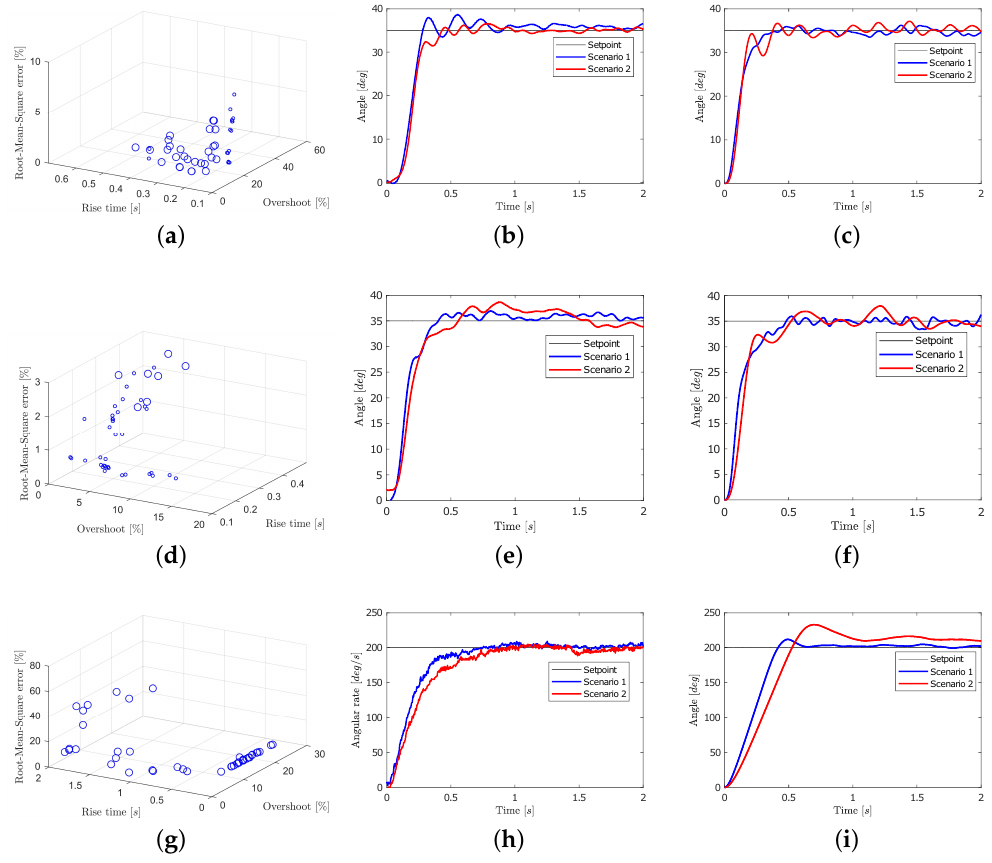
Figure 12. ( a ) Pareto front roll. ( b ) Roll axis response test. ( c ) Roll axis response simulation. ( d ) Pareto front pitch. ( e ) Pitch axis response test. ( f ) Pitch axis response simulation. ( g ) Pareto front yaw. ( h ) Yaw rate axis response test. ( i ) Yaw rate axis response simulation.